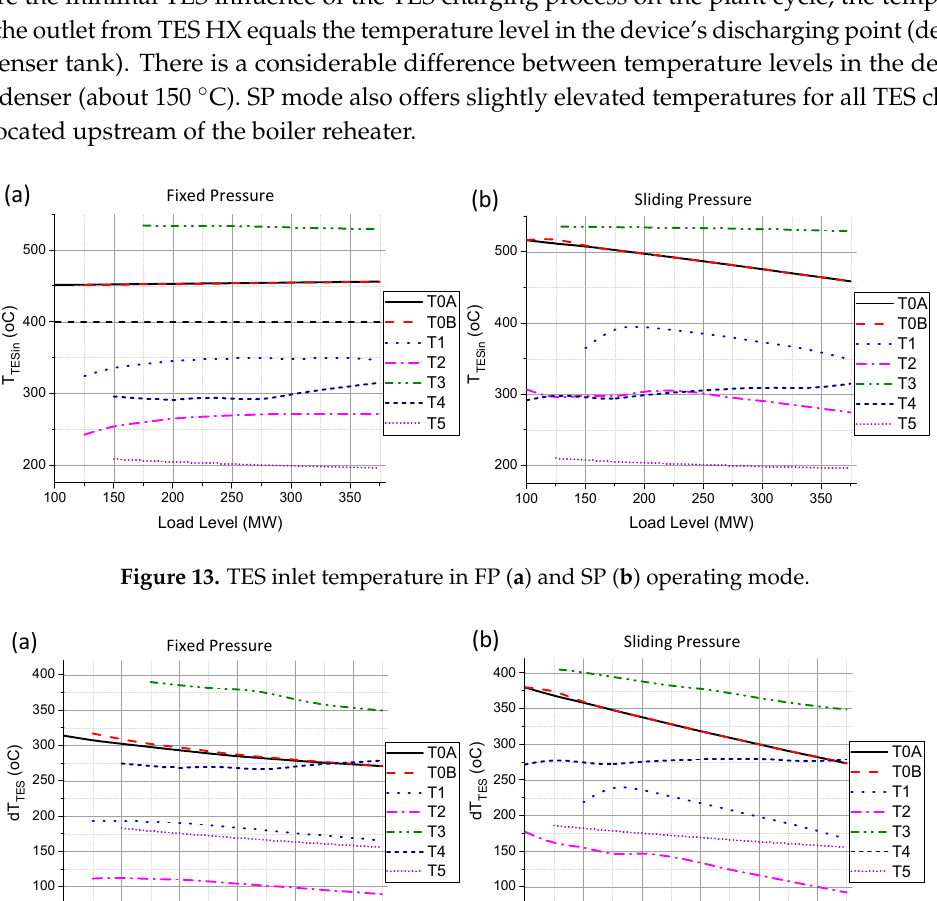
Figure 14. Temperature gradient across the TES tank in FP ( a ) and SP ( b ) operating mode. Unit generation efficiency ( η UNIT ) during the TES charging process is depicted in Figure 15. The dash-dotted black line represents the unit efficiency without the TES charging process (no TES).